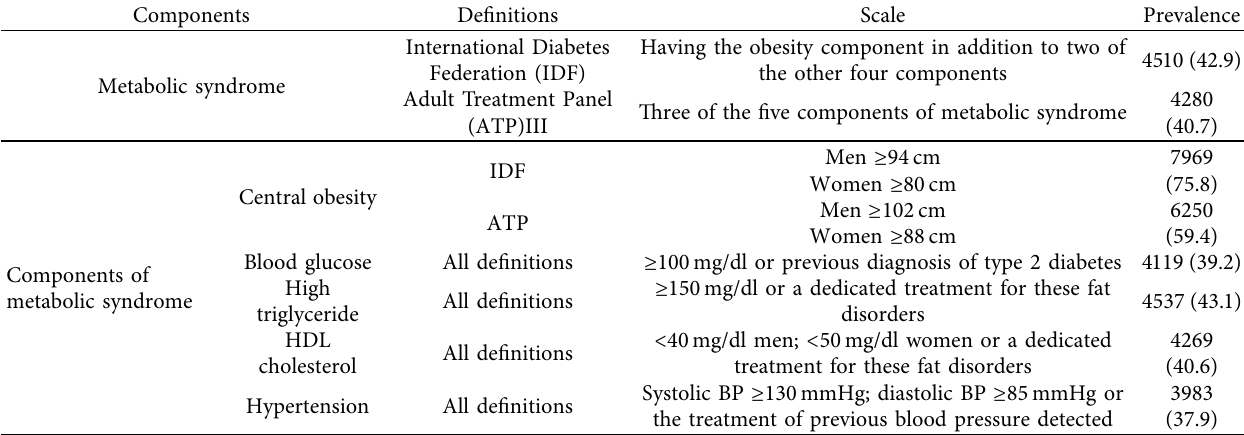
Table 2: Definitions and frequency of metabolic syndrome and its